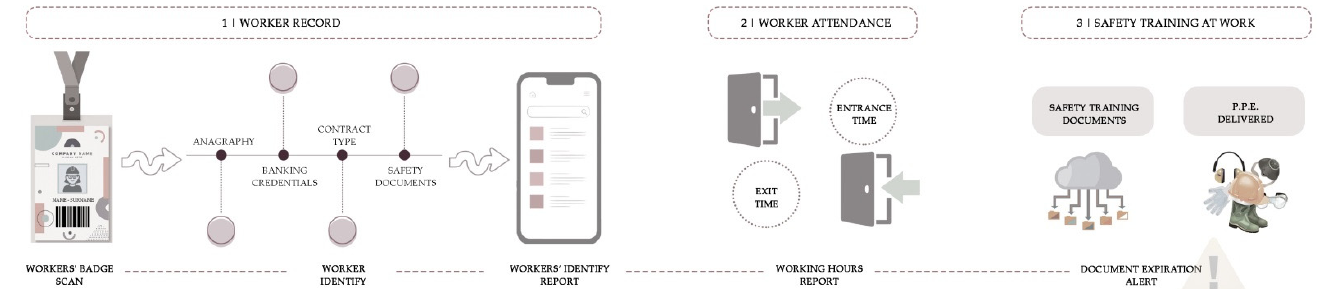
Figure 9. Casting concrete monitoring-checklist.